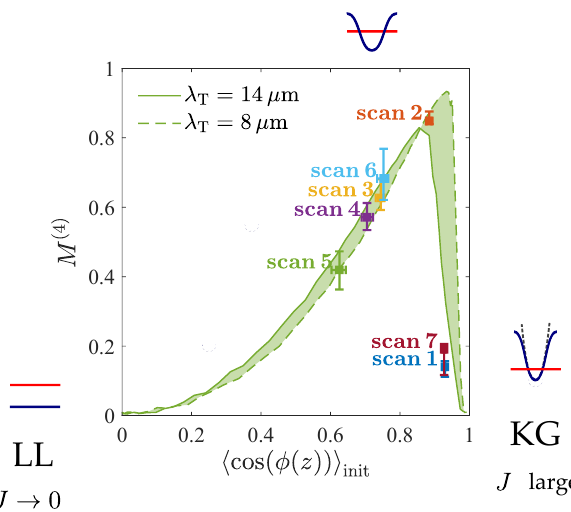
Figure 4: Characterization of the initial states of the experimental scans of Ref. [ 24 ] . Plot of the observed value of M ( 4 ) in the initial equilibrium state as a function of the observed coherence factor 〈 cos φ 〉 as first explored in Ref. [ 22 ] . The initial state of scan 1 and 7 corresponds to large J , i.e., the Klein-Gordon (KG) regime and is Gaussian, while those of scans 2 to 6 are non-Gaussian, with the highest value of non- Gaussianity reached for scan 2. For small J the system is in the Tomonaga-Luttinger liquid regime (TLL). The green curves correspond to theoretical simulations of the sine-Gordon model at thermal equilibrium ( λ represents the thermal coherence T length) based on the classical field approximation [ 27 ]